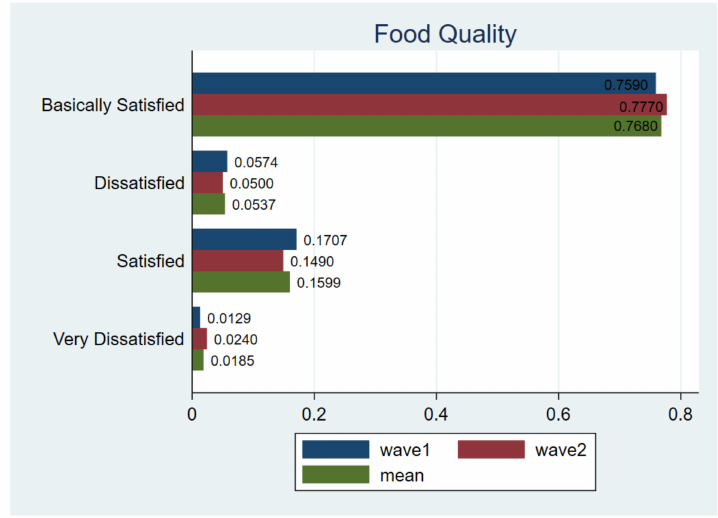
Figure 10. Comparing food quality. Notes: t -test for H 0 : equal variance assumed: t value = − 14.8343, Pr (|T| > |t|) = 0.0000; wave1 vs. wave2.